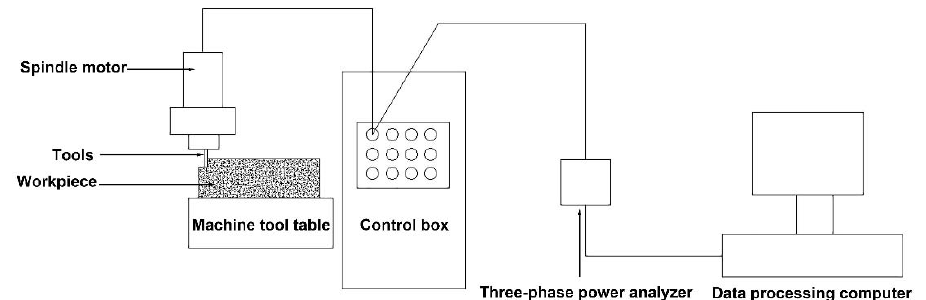
Figure 1. Power signal acquisition system.